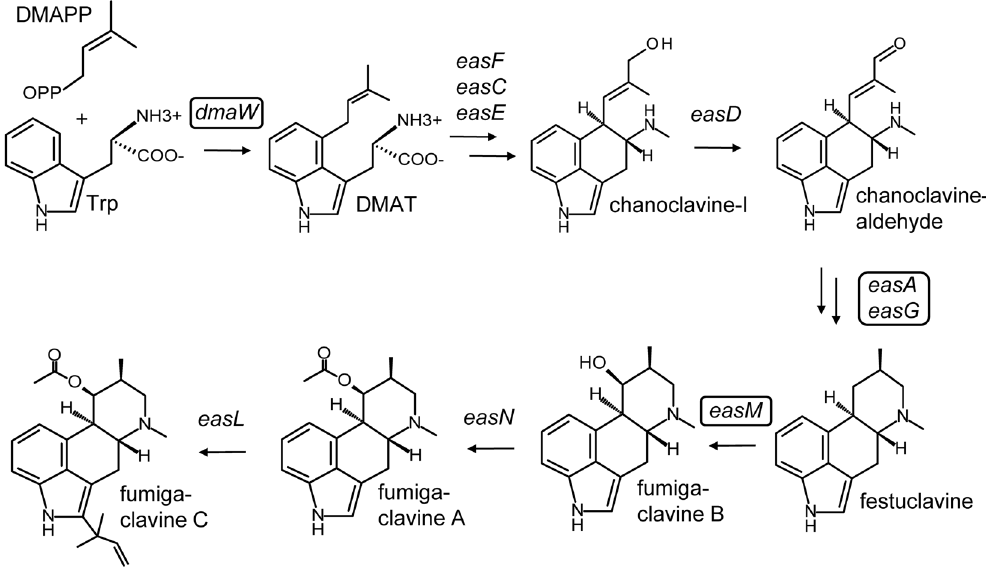
Figure 1. Important intermediates and end product of the ergot alkaloid pathway of N. fumigata . Genes controlling pathway steps are indicated, and genes knocked out in strains included in the present study are outlined. DMAPP, dimethylallylpyrophosphate; Trp, tryptophan, DMAT, dimethylallyltryptophan. Double arrows indicate additional, non-illustrated